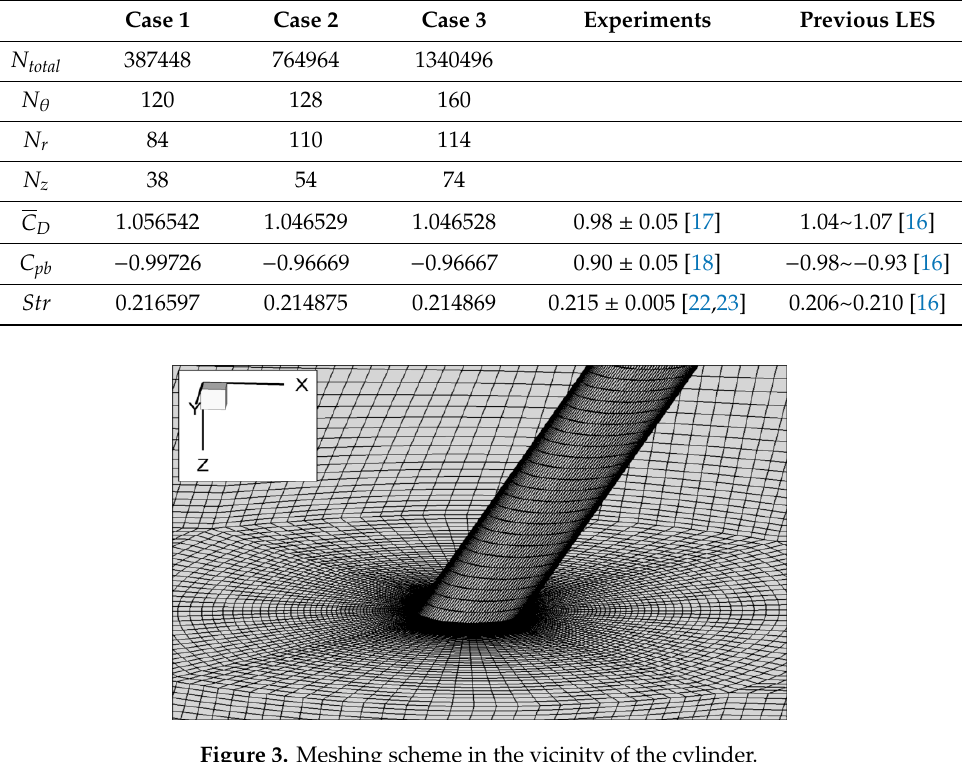
Figure 3. Meshing scheme in the vicinity of the cylinder.